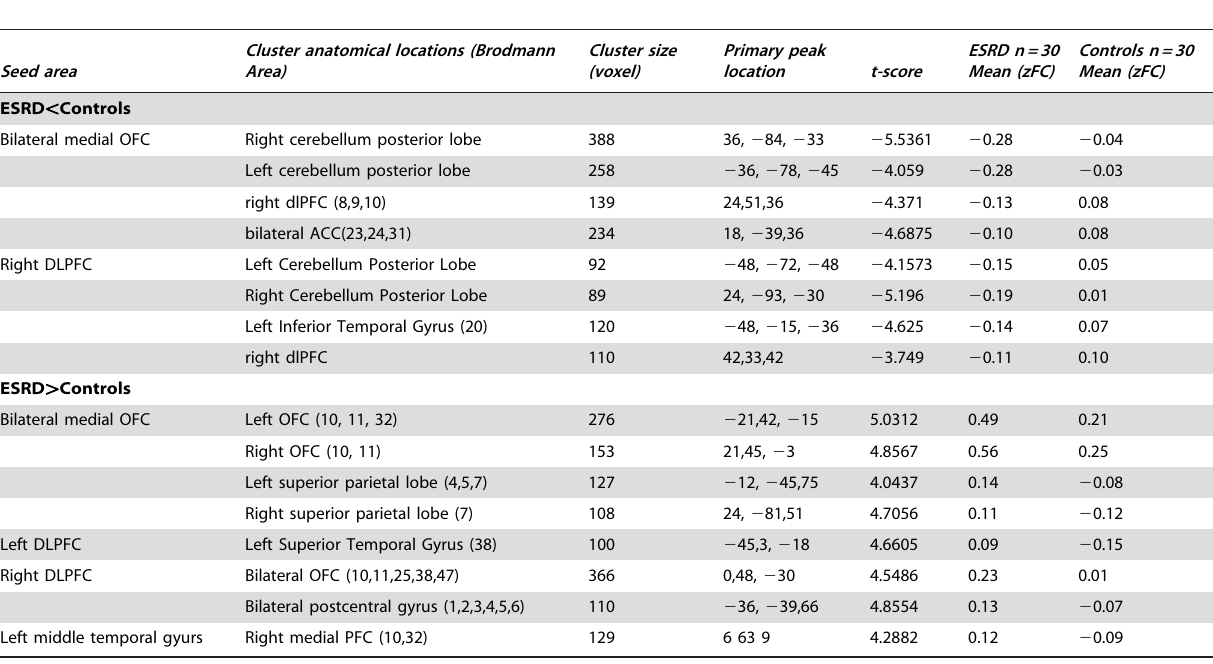
Table 3. Significant differences between ESRD Patients and Controls in resting state functional connectivity for the four seed areas (showed different in group comparison) and the rest of the